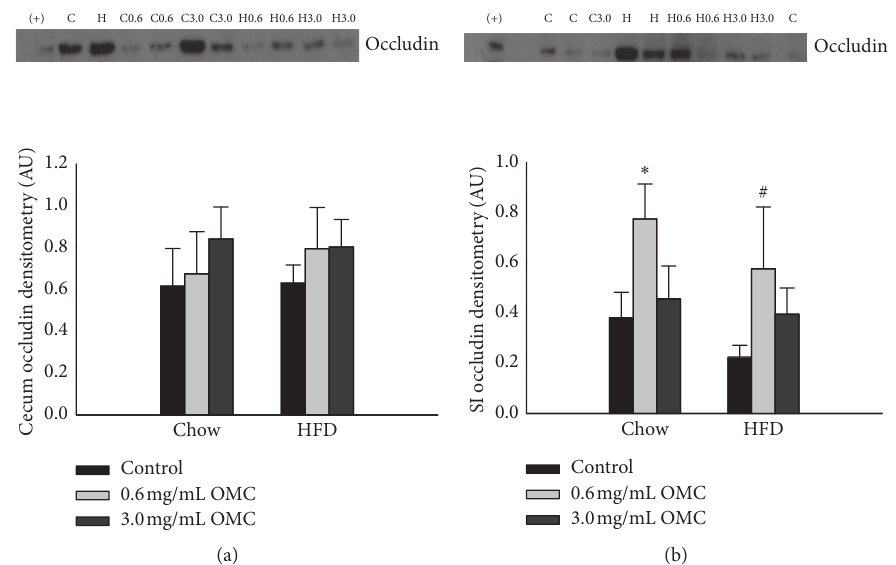
Figure 2: Occludin protein expression in the cecum and small intestine (SI). (a) Occludin protein expression in cecum homogenates from rats in all treatment groups ( n � 5-6/group), p � 0 . 686. Effects of OMC supplementation on occludin expression, p � 0 . 605. Diet vs dose interaction, p � 0 . 943. (b) Occludin protein expression in small intestine homogenates from rats in all treatment groups ( n � 5-6/group), p � 0 . 259. Effects of OMC supplementation on occludin expression, ∗ p < 0 . 05 Chow 0.6mg/mL OMC vs Chow, and # p < 0 . 05 HFD 0.6mg/ mL OMC vs HFD. Diet vs dose interaction, p � 0 . 891. Densitometry values were normalized to Coomassie for all samples. Data are expressed as mean ± SEM and analyzed by two-way ANOVA.